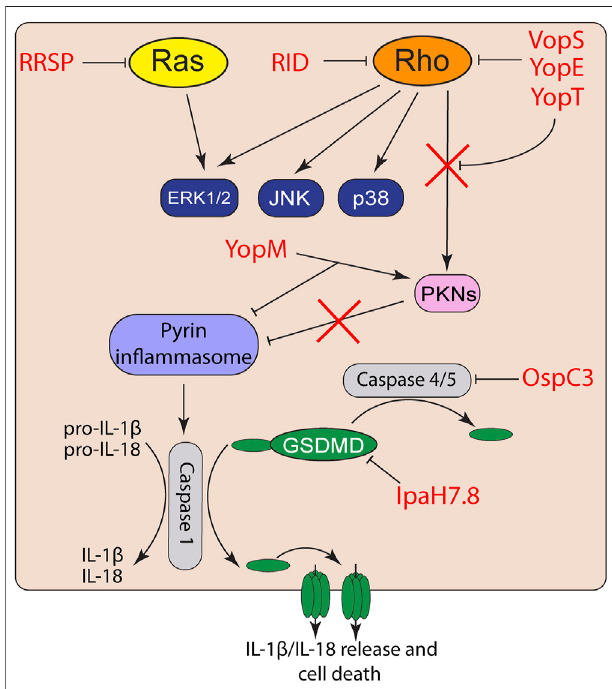
FIGURE 2 | Effector activation and suppression of effector triggered immunity.ToxinandeffectortargetingofRhoGTPasestriggeractivationofthe pyrin in fl ammasome. However, bacterial pathogens also co-deliver effectors to suppress in fl ammasome activation or inactivate proin fl ammatory caspases and